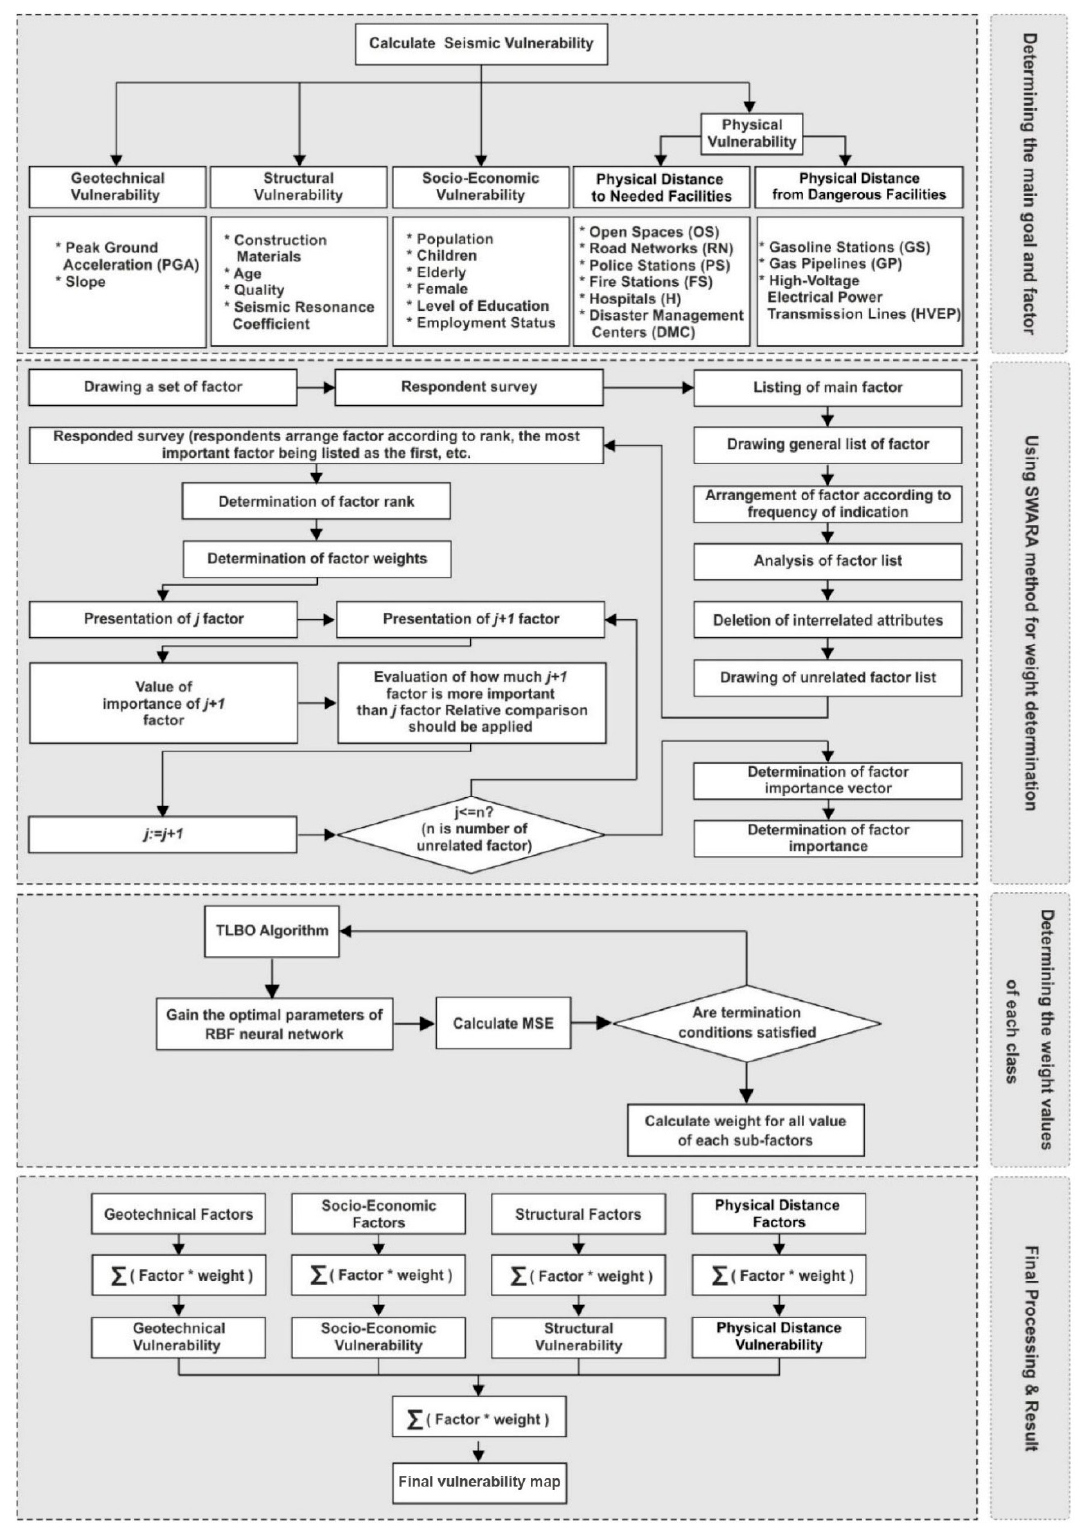
Figure 2. The proposed flowchart of the software.